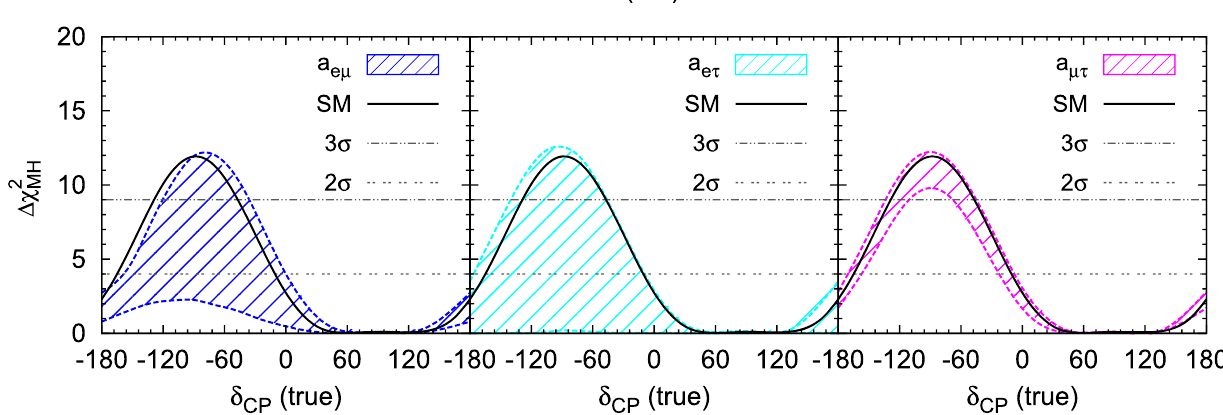
Fig. 7 Mass hierarchy sensitivity as function of δ CP for NO ν A exper- iment. Left (right) panel is for NH (IH) as true value. Black curve represents the standard matter effect case without any LIV parameter.